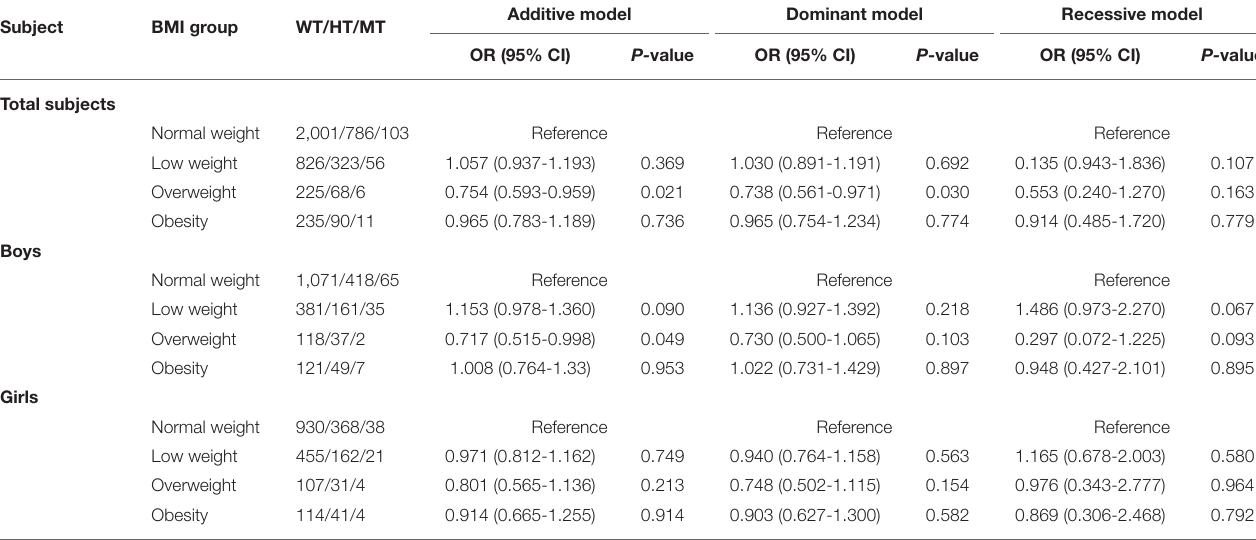
TABLE 3 | Association analysis of GHR fl/d3 polymorphism with BMI.